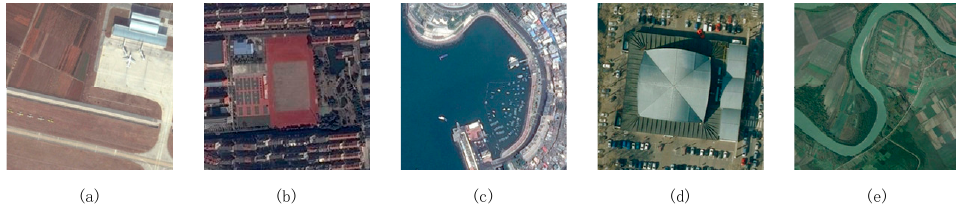
Figure 6. Multi-scene semantic RS images in MSIRTS, each of which contains two distinct types of scene semantics. ( a ) Airport and Farmland; ( b ) Playfields and Dense residential; ( c ) Port and Dense residential; ( d ) Parking and Center; ( e ) River and Farmland.